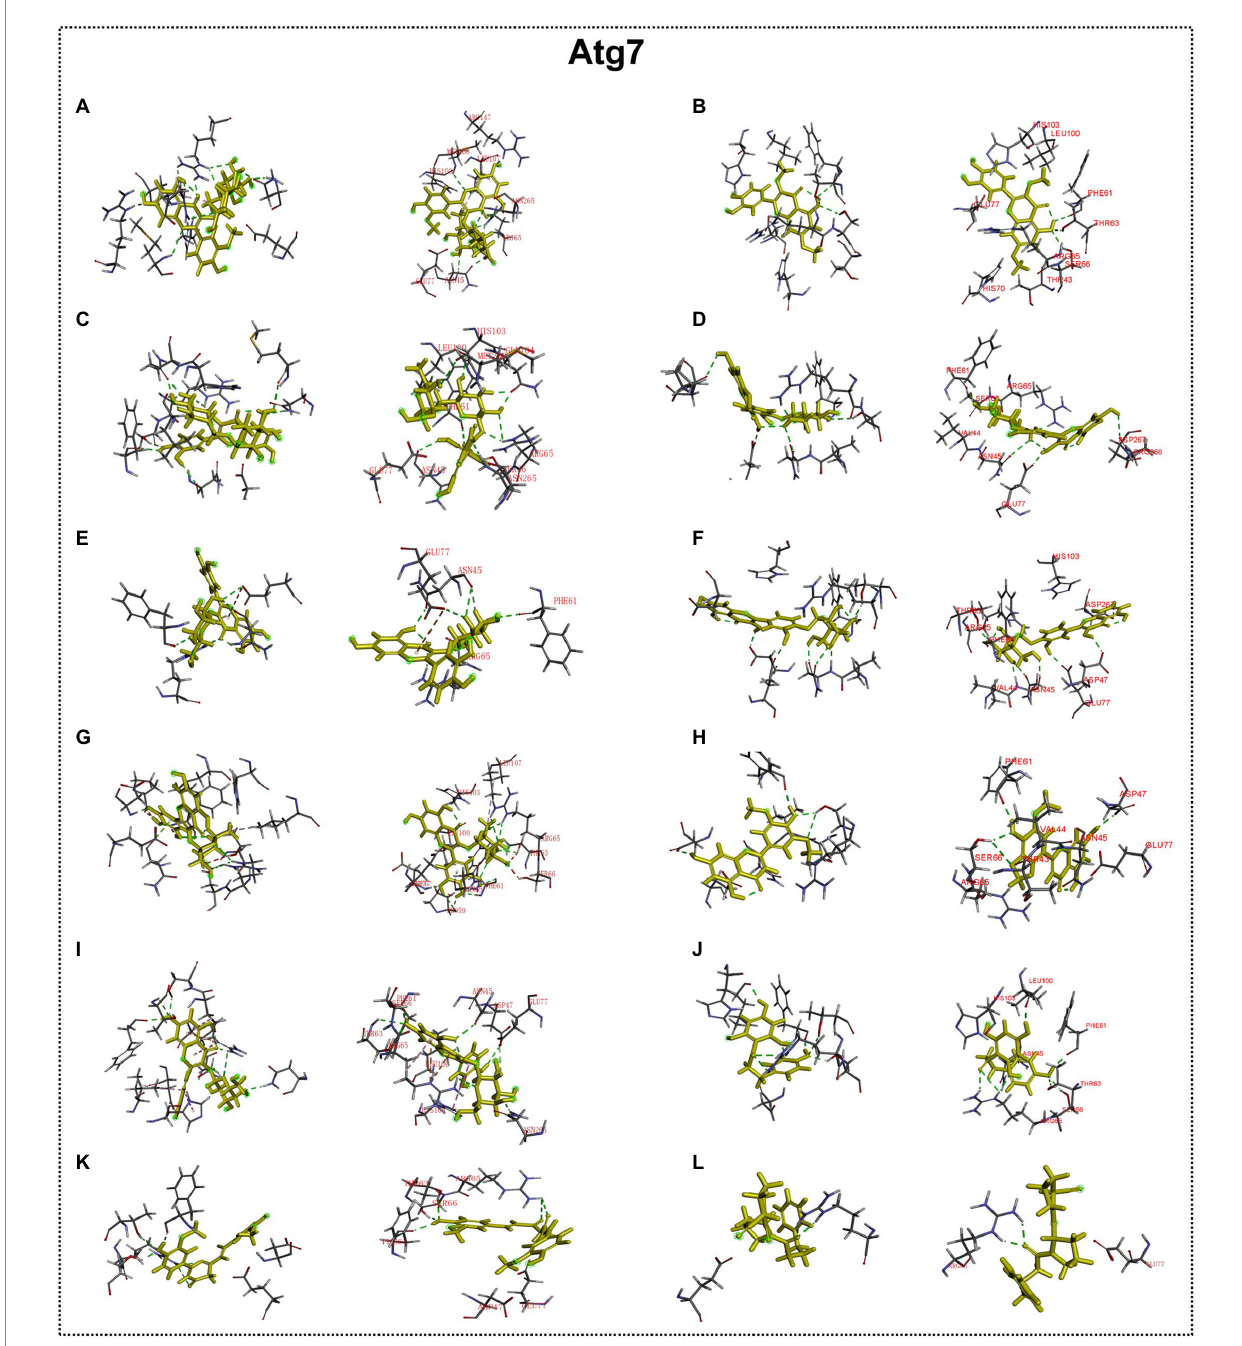
FIGURE 10 Docking simulation of the interaction between main flavonoid compounds of ECoL and the receptor Atg7 in general overview and local overview. Isorhamnetin-3-O-neohespeidoside (A) , di-O-methylquercetin (B) , rutin (C) , quercetin-3’-O-glucoside (D) , isoquercitrin (E) , spiraeoside (F) , myricitrin (G) , tricin (H) , hyperoside (I) , phloretin (J) , curcumin (K) , and KYP-2047 (L) were used as molecularly docked